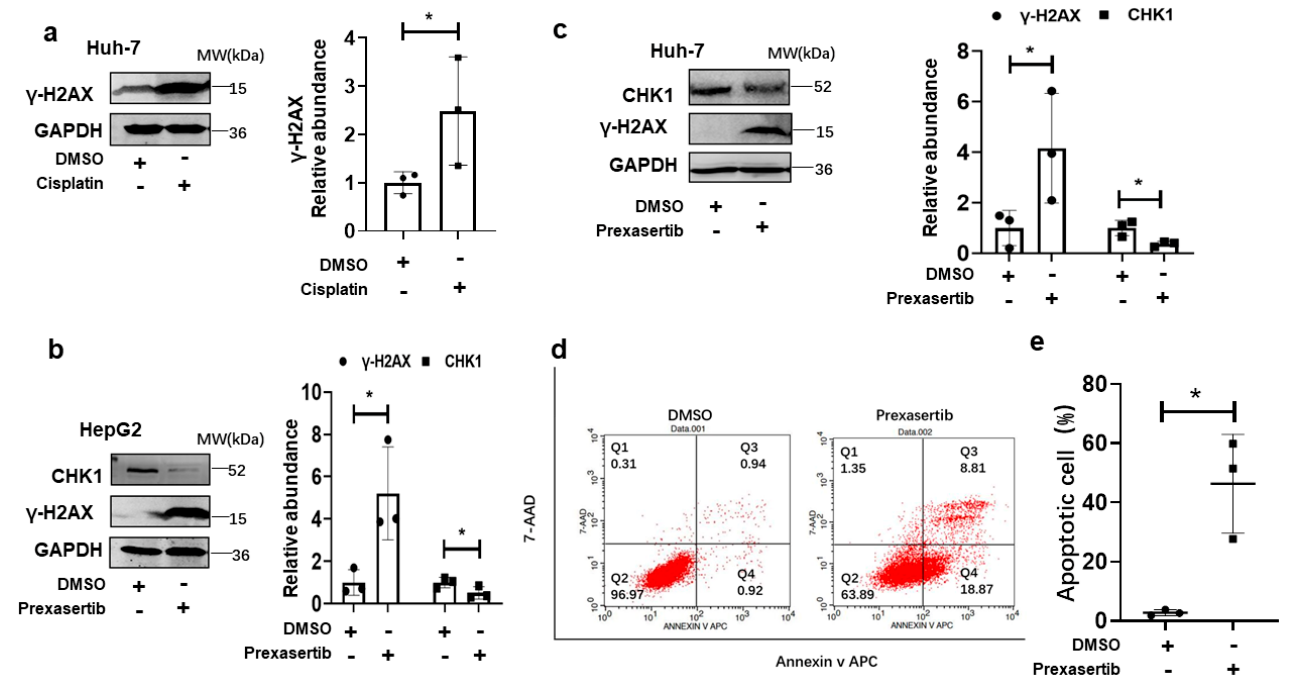
Figure 2. CHK1 inhibition induces DNA damage to cause apoptosis in HCC cells. ( a ) Western blot and quantitative analysis for γ -H2AX level is shown in Huh-7 cells induced by cisplatin (5 μ M) for 24 h. The γ -H2AX expression is measured by western blot in HepG2 ( b ) and Huh-7 cells ( c ) induced by prexasertib with a dose of 5 μ M for 24 h. ( d ) Representative image of FACS analysis of apoptotic Huh-7 cell rate treated with DMSO or prexasertib with a dose of 5 μ M for 24 h are shown. ( e ) The statistical summary of apoptotic Huh-7 cell rate is shown with t test ( n = 3). Data represent mean ± SD, * p < 0.05. Western blot image shown are representative of 3 experiments. FACS assay shown are representative of 3 independent experiments. The uncropped blots are shown in Supplementary Figure S1.